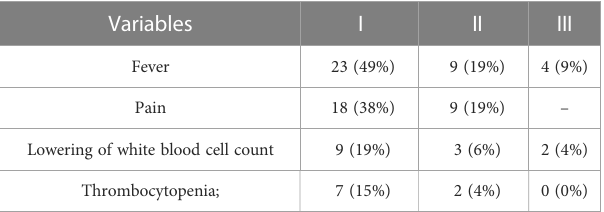
TABLE 3 Adverse effects after oncolytic virus injection.